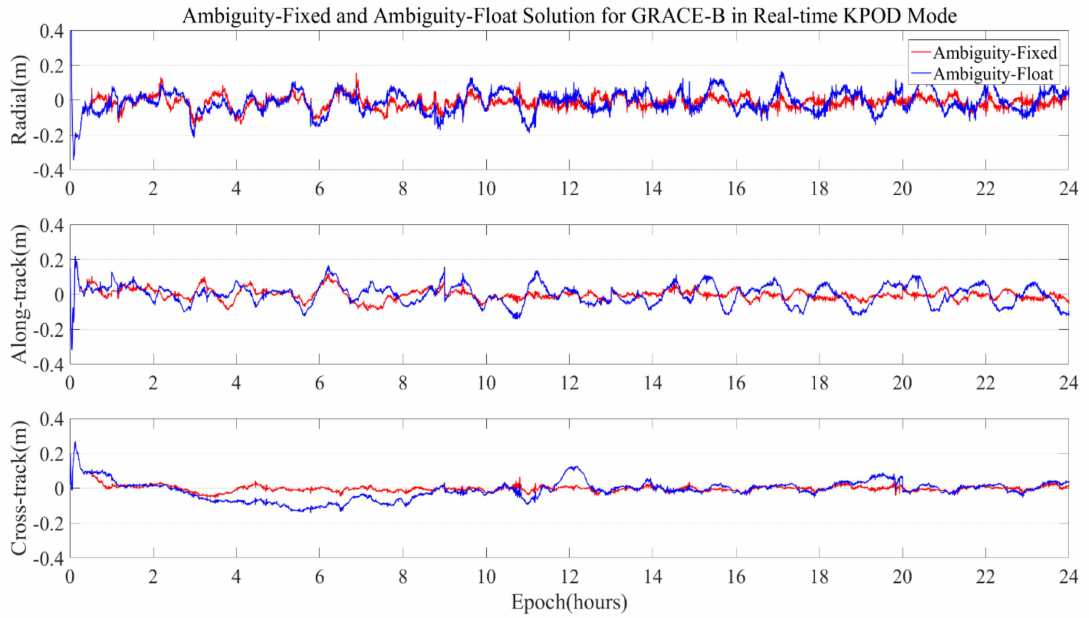
Figure 5. Orbital differences of GRACE-B ambiguity-fixed and ambiguity-float KPOD based on comparison with reference orbits.